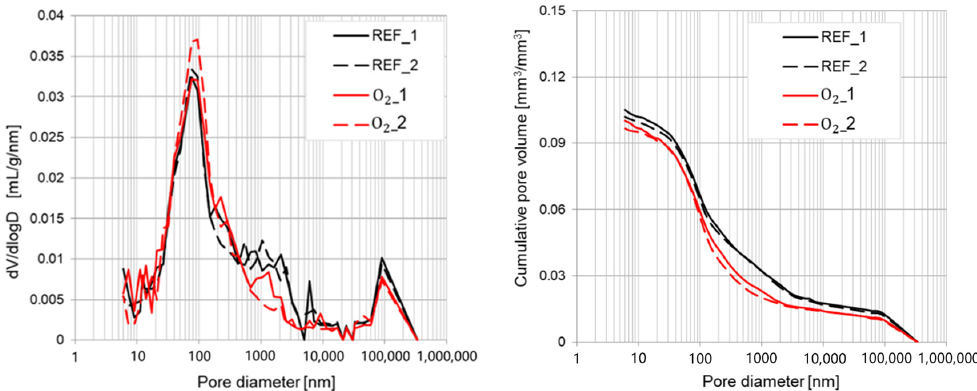
Figure 12. Pore size distribution of the concrete specimens with water comprising micro-nano oxygen bubbles (O 2 ) compared to the reference samples (REFs).